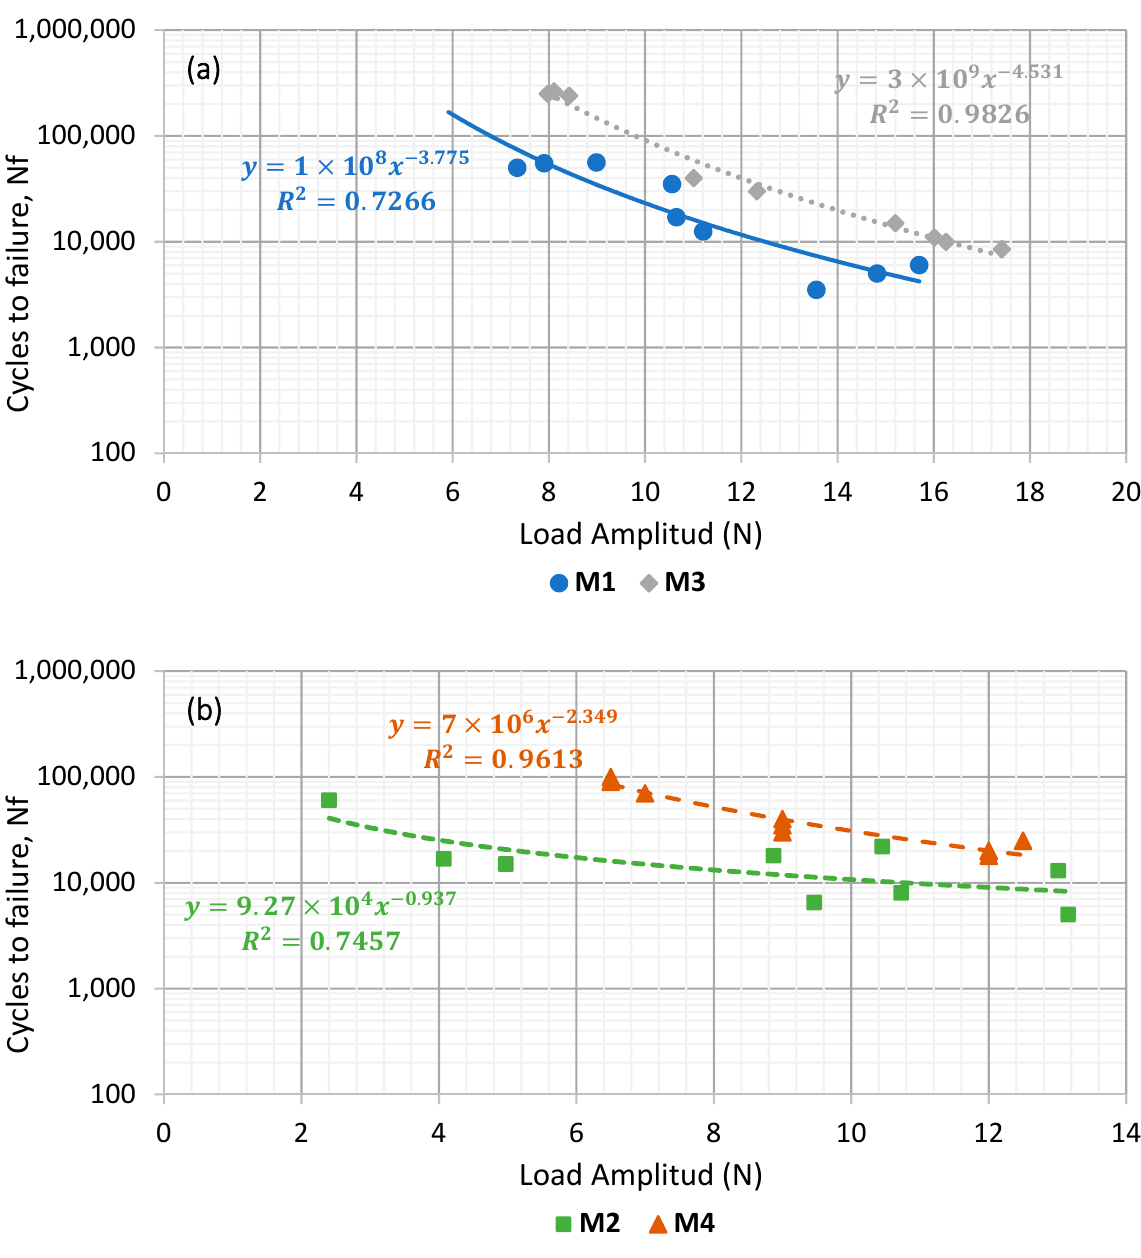
Figure 8. Comparison between types of bitumen for mortars manufactured with Portland cement ( a ) and CaCO 3 ( b ).